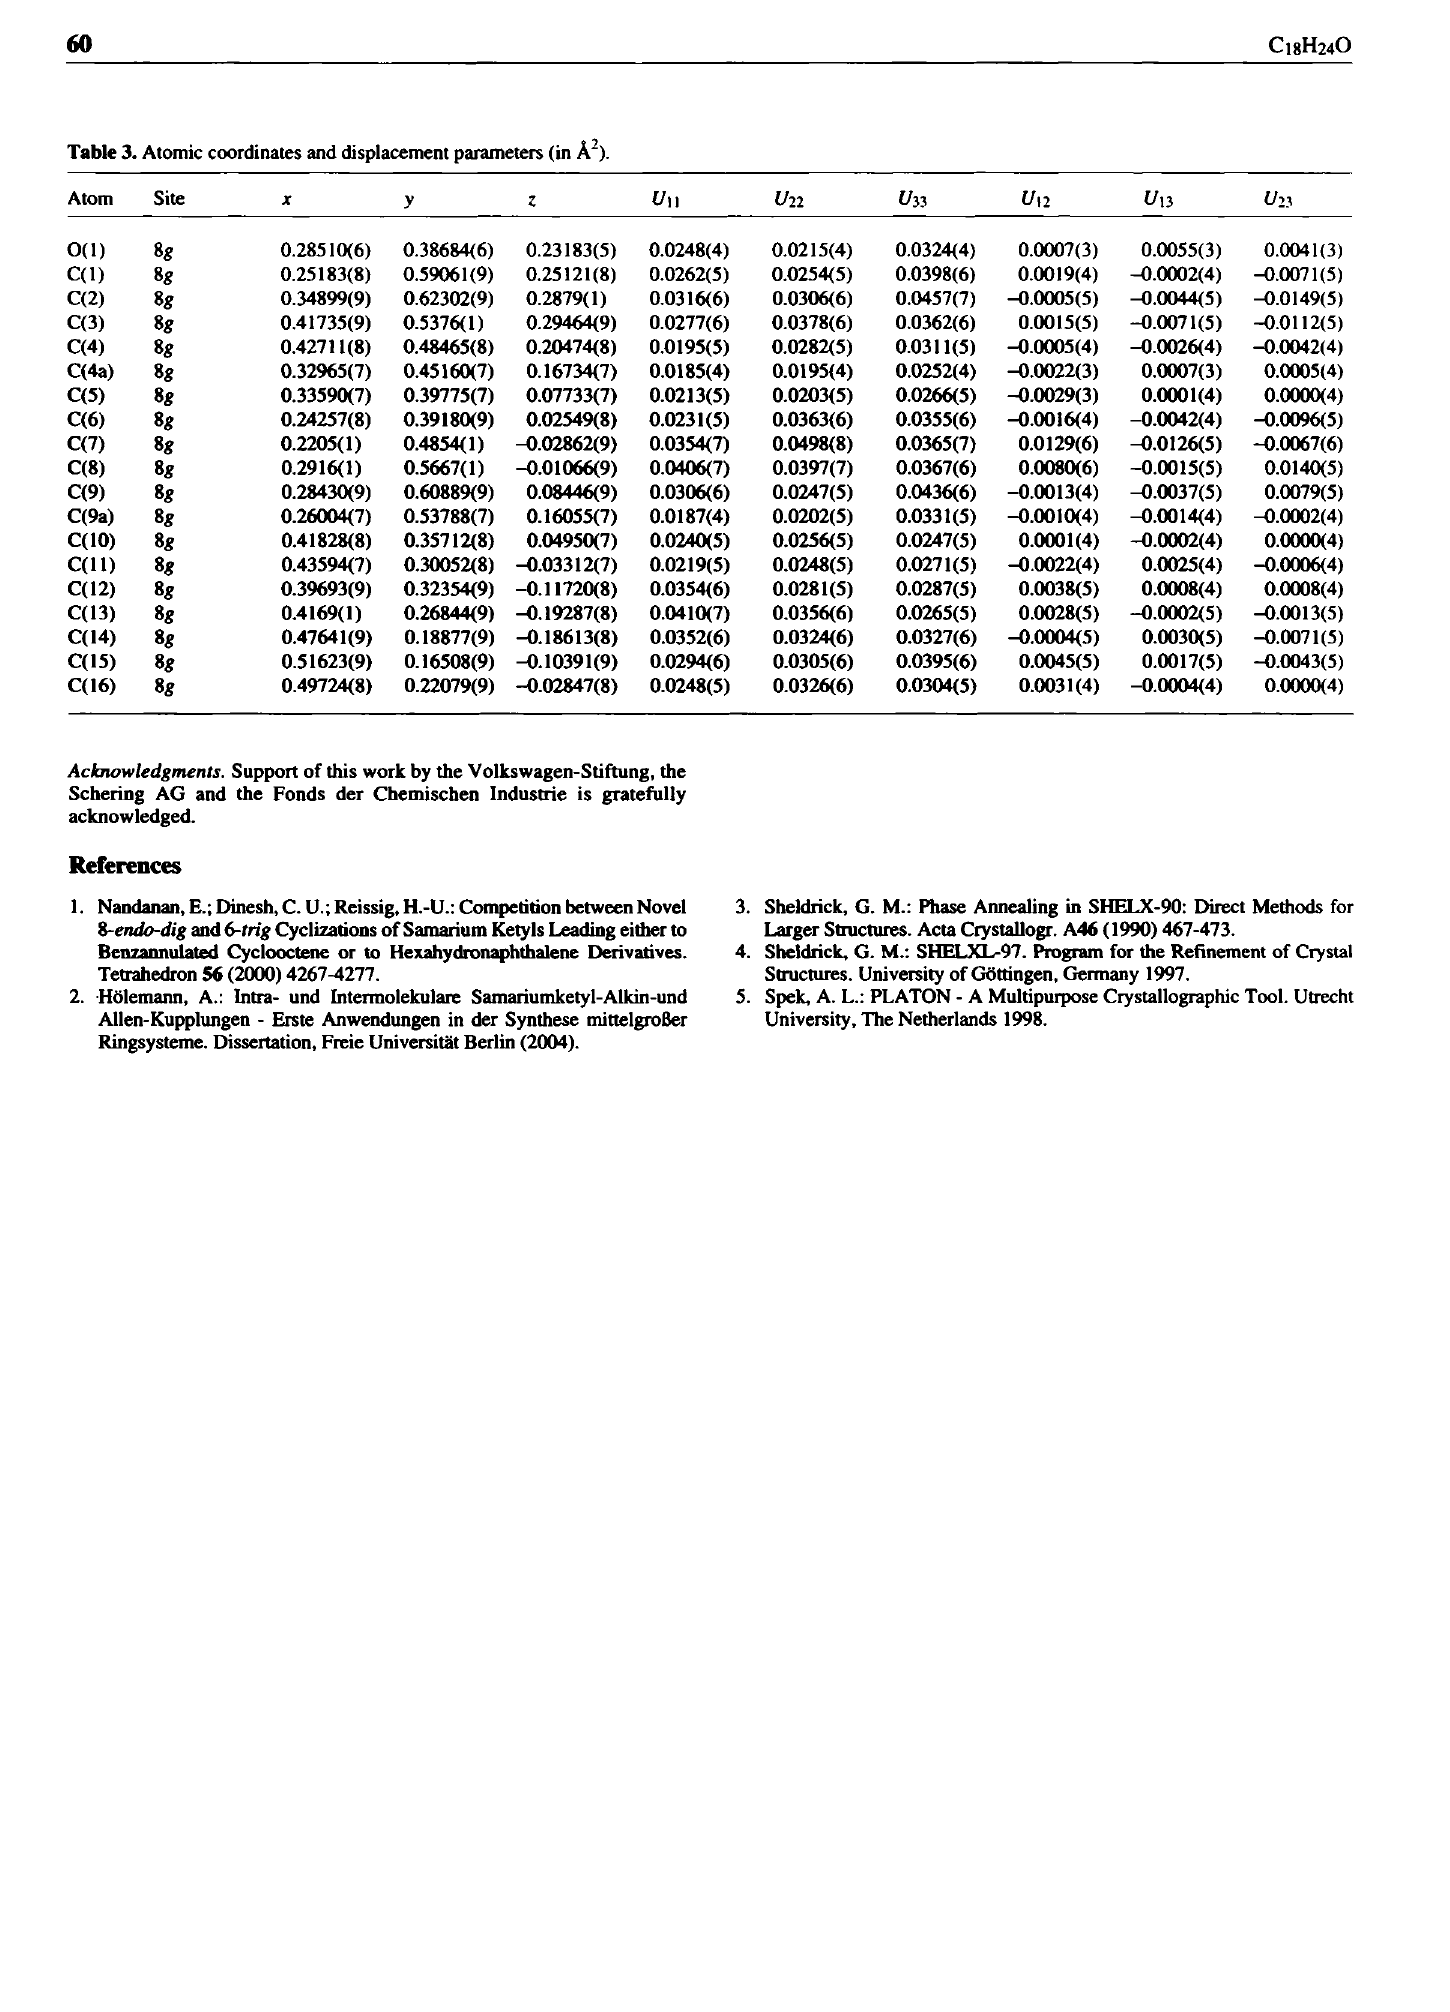
Table 3. Atomic coordinates and displacement parameters (in Ä 2